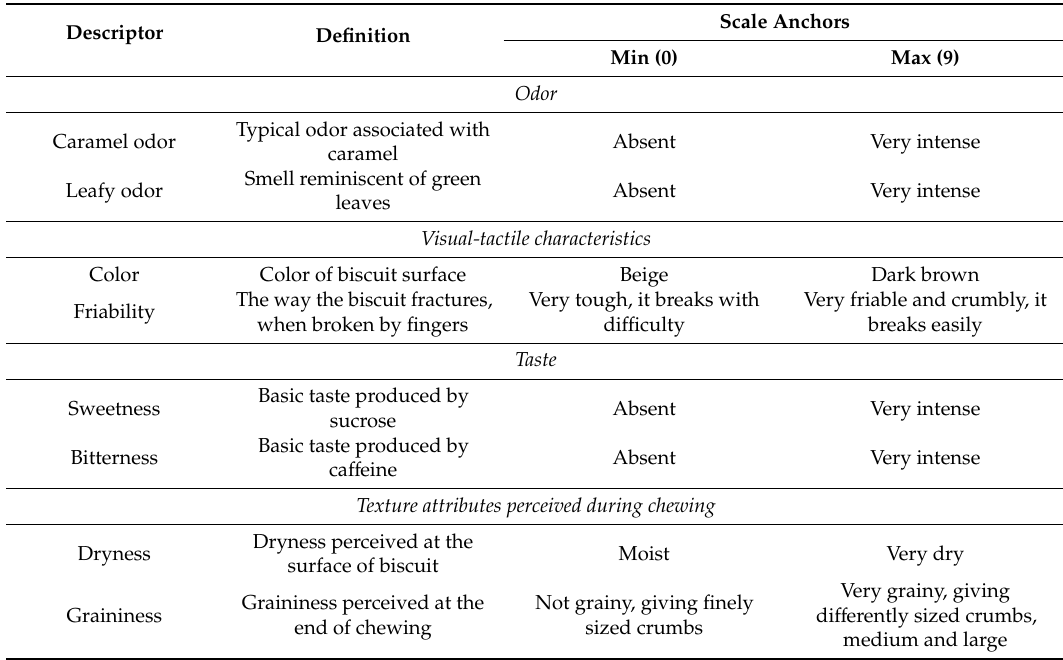
Table 2. Descriptive terms used for the sensory profiling of biscuits.